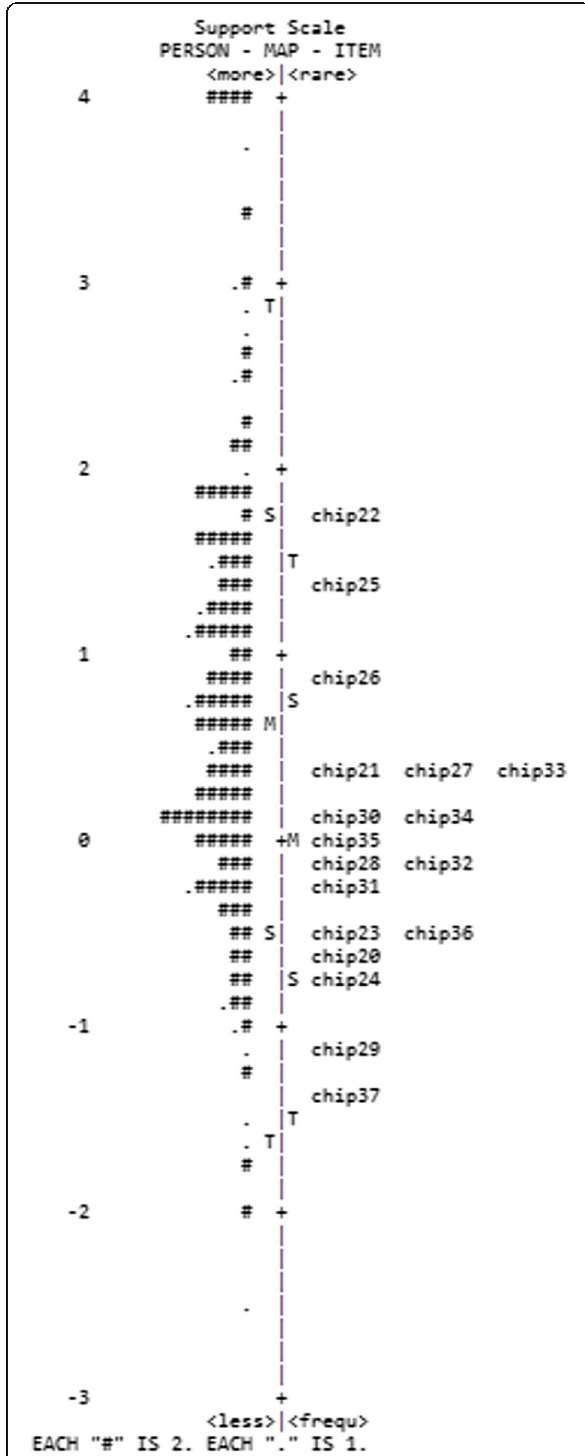
Fig. 3 Item-person map for the medical dimension of the